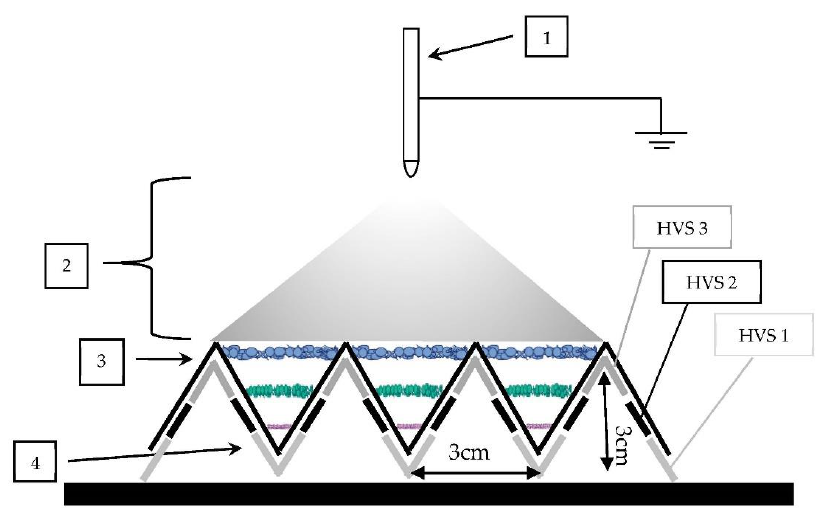
Figure 12. The schematic set-up for the production of three nanofiber layers by sequential voltage connection of blades deposited onto V-shaped substrate: 1—needle supplying polymer solution, 2—nanofibers being formed by the elongation of an electrified fluid jet, 3—V-shaped substrate, 4—three sets of metal